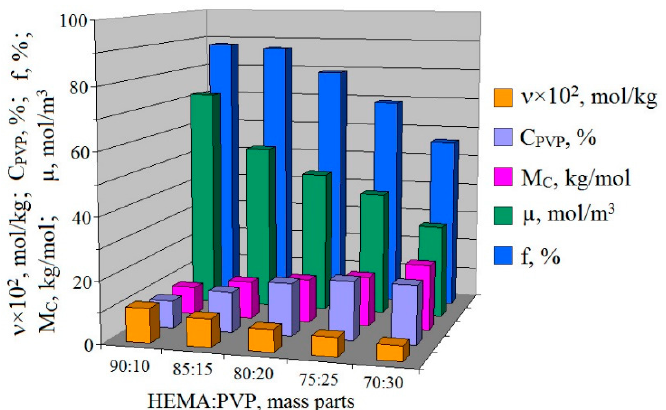
Figure 3. The effect of the initial composition formulation on the structural characteristics of pHEMA-gr-PVP copolymers.